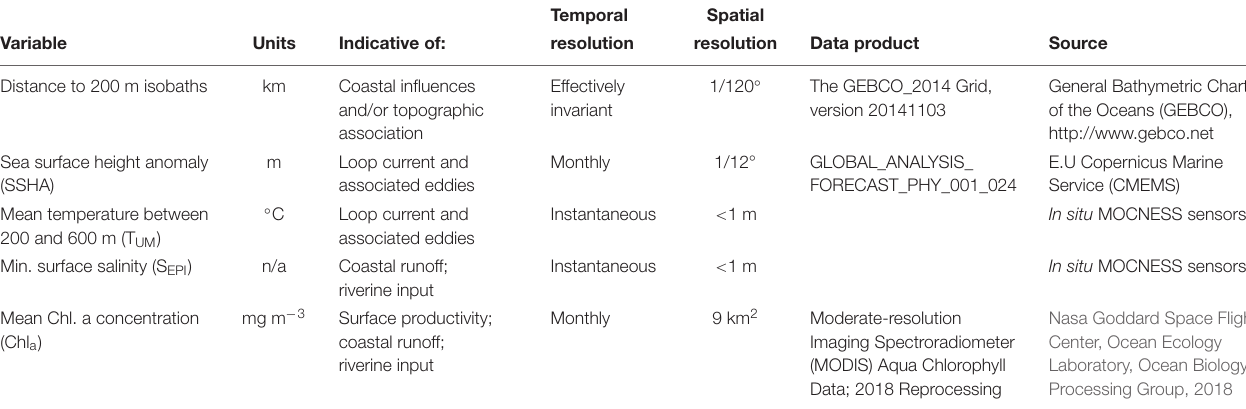
TABLE 1 | Environmental variables selected for inclusion in the multivariate analyses and their suggested